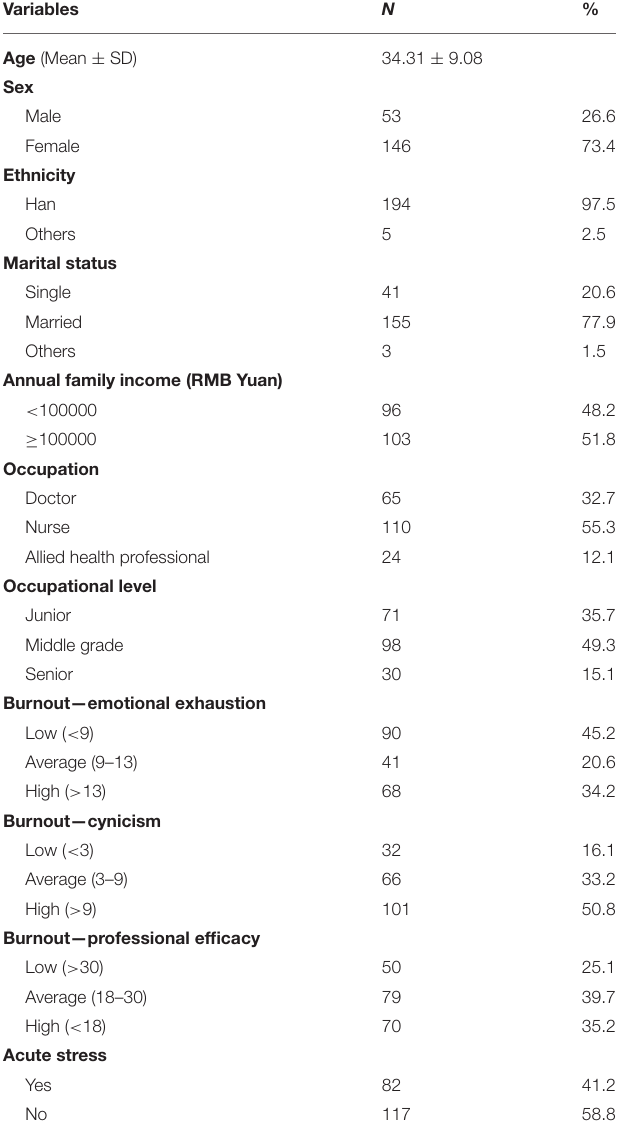
TABLE 1 | Sociodemographic characteristics of the health